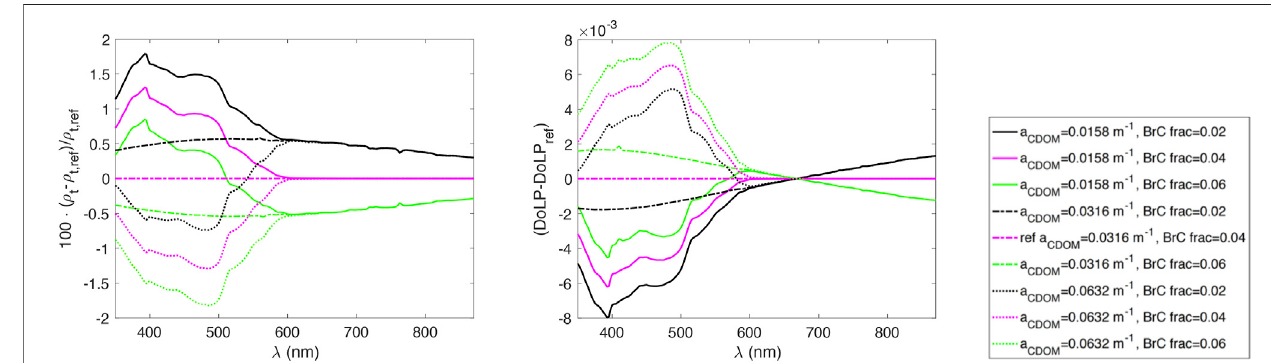
FIGURE 5 | Left: the percentage difference of the TOA re fl ectance with respect to a reference case (ref), which corresponds to a CDOM ( 440 ) (cid:2) 0 . 0316 m − 1 and the brown carbon aerosol fraction of 0.04, i.e., the dash magenta color line. Right: the absolute difference of the TOA DoLP with respect to the reference case (ref).